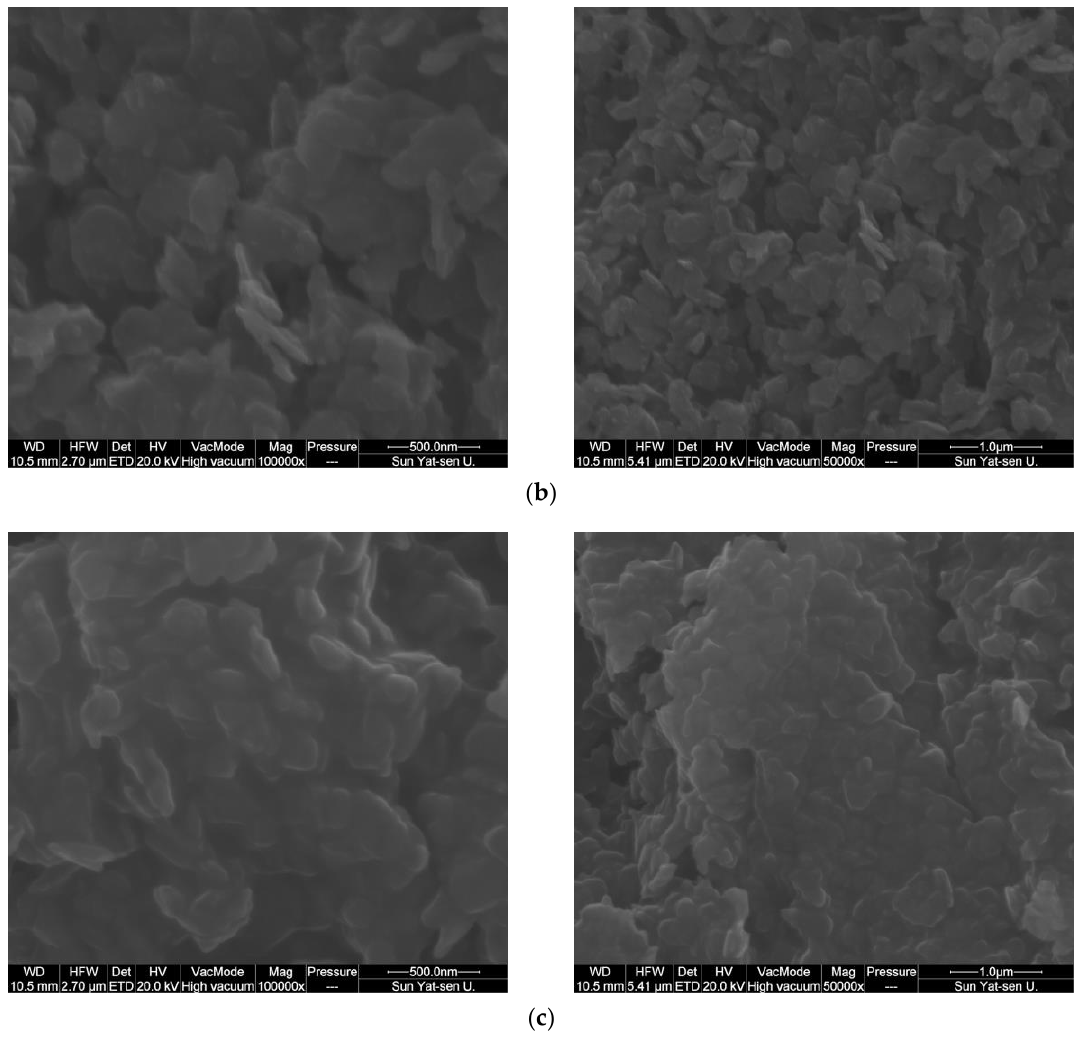
Figure 3. SEM images of: ( a ) Co-Ni(0); ( b ) Co-Ni(t); ( c ) Co-Ni(P).